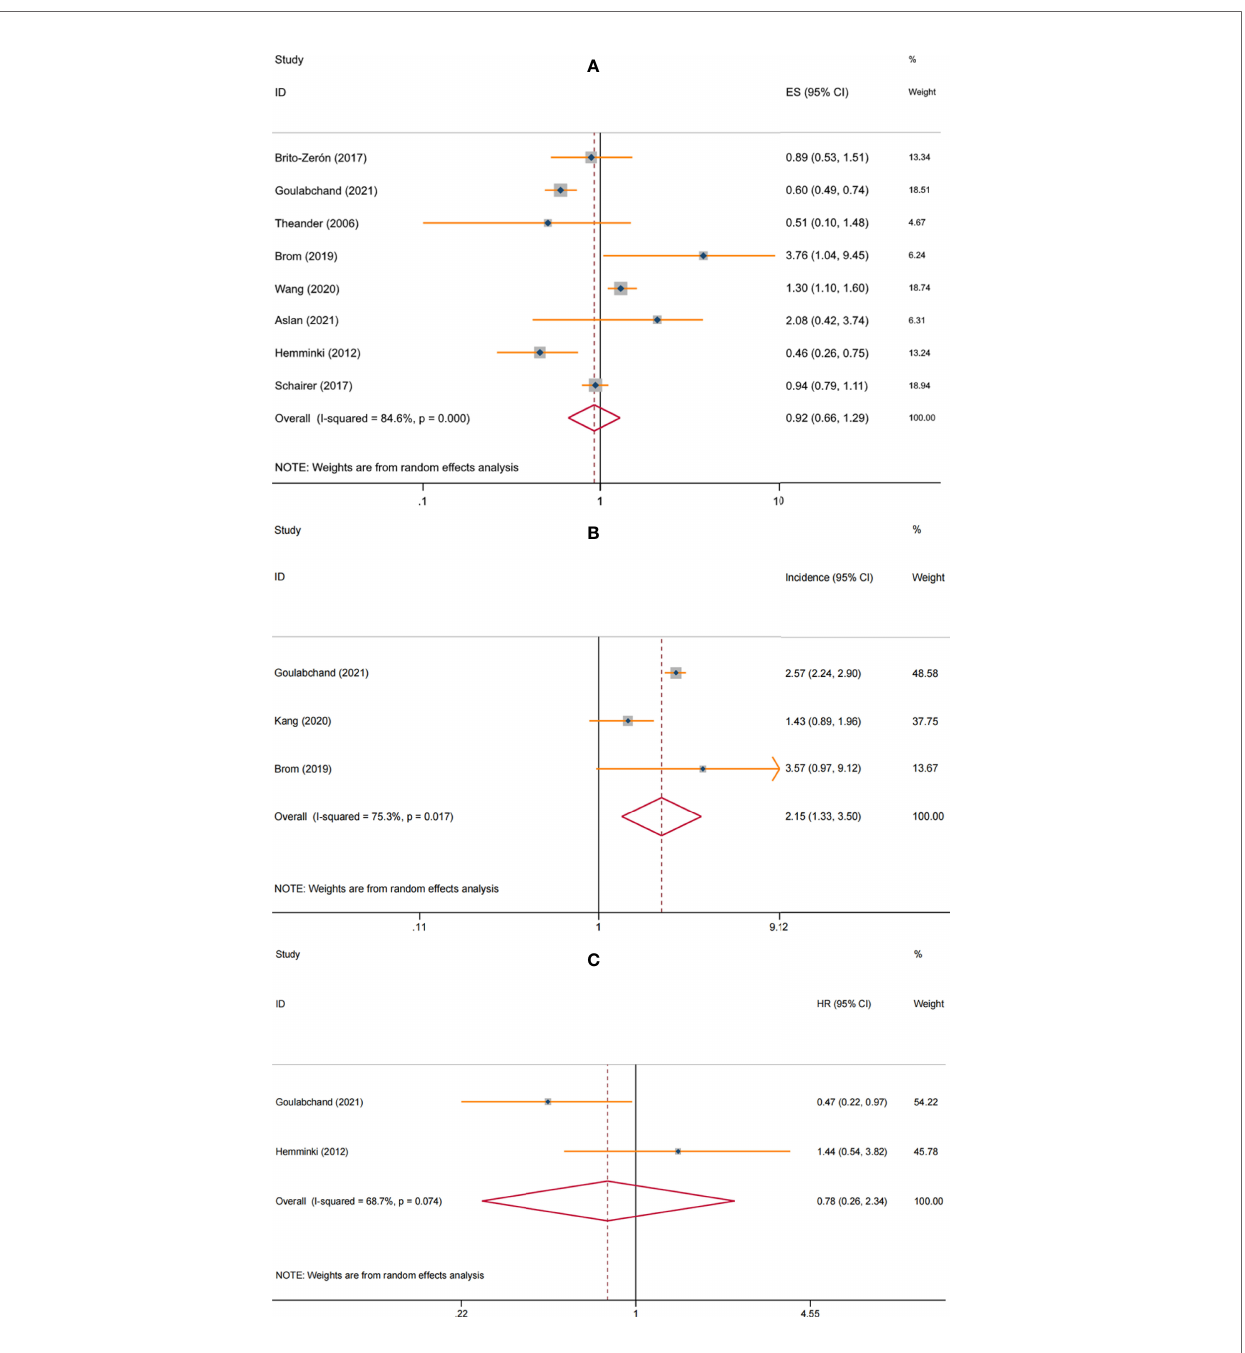
FIGURE 2 | Forest plot of the associations between primary Sjögren ’ s syndrome and breast cancer: (A) risk; (B) incidence; (C)